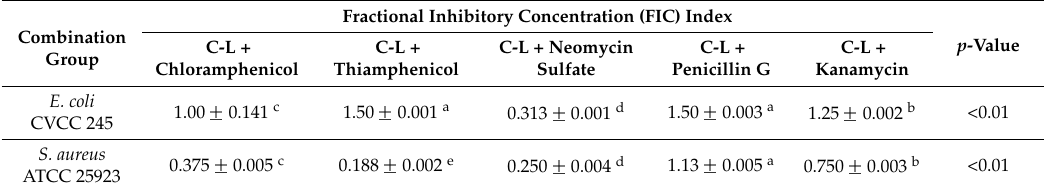
Table 5. Synergistic interaction of C-L with five